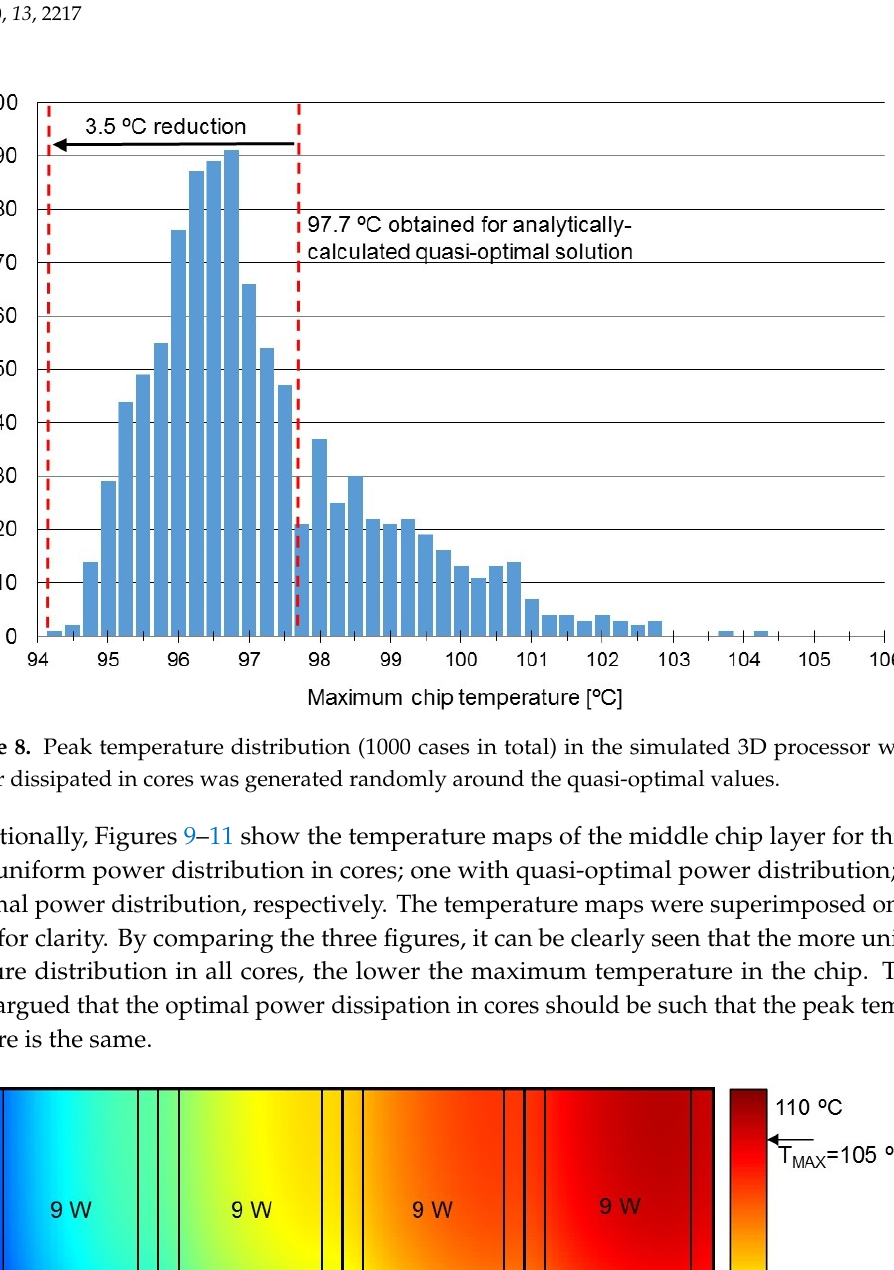
Table 3. Power dissipated in cores and the respective peak temperatures for three cases. Power dissipation in cores in the second processor layer is exactly the same, so it was not shown.